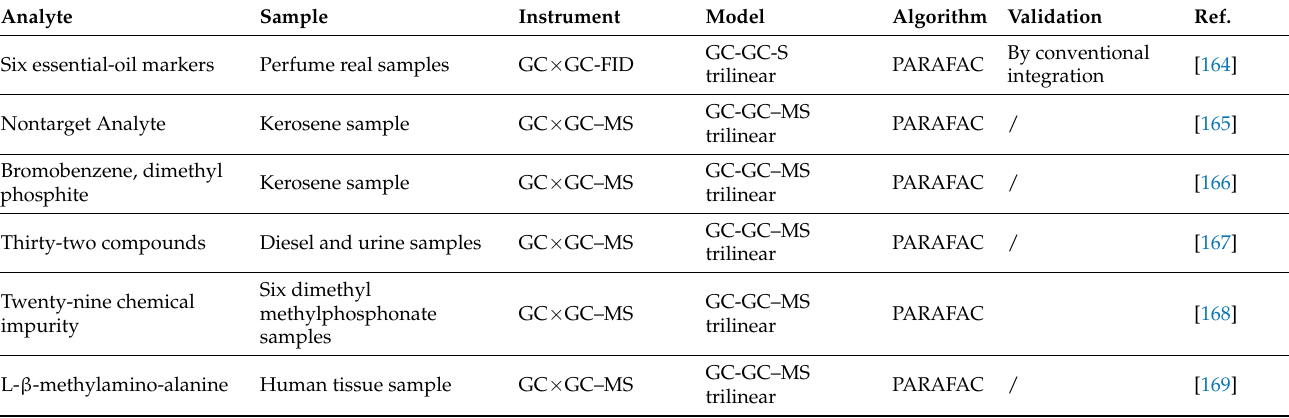
Table 7. Analytical applications of comprehensive two-dimensional gas chromatography–flame ionization detection (GC × GC-FID) and comprehensive two-dimensional gas chromatography–mass spectrometry (GC × GC–MS) assisted by multiway analysis based on the multilinear model.